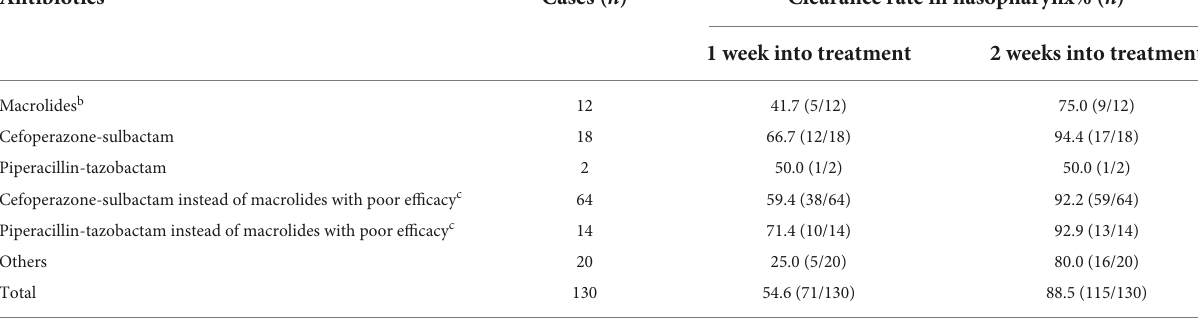
TABLE 5 The clearance rate of B. pertussis in treatment with different